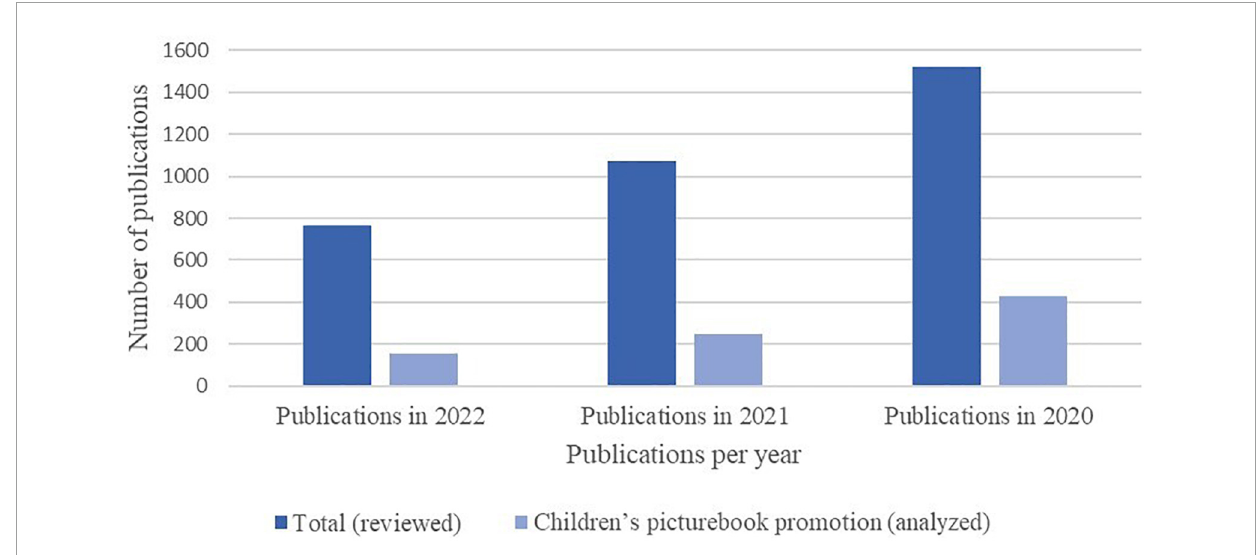
FIGURE1 Audio-visual documents published on YouTube or Vimeo by